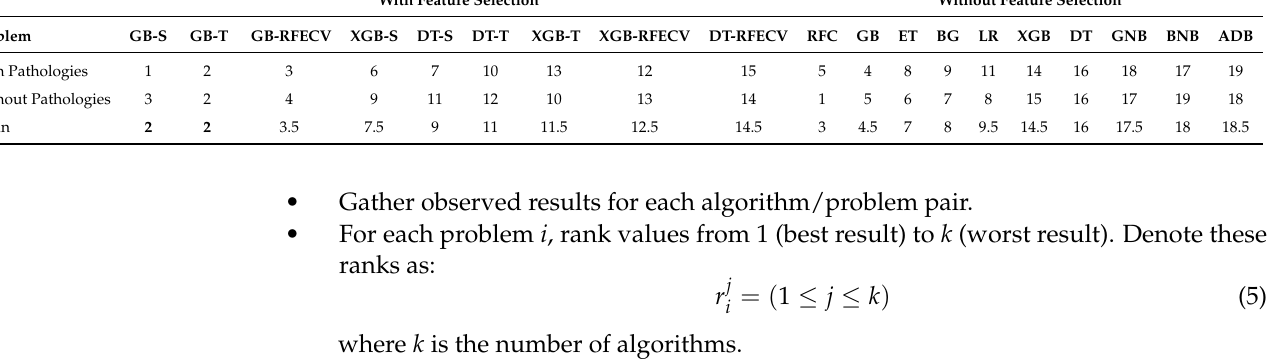
Table 6. Friedman Ranks for the different proposed algorithms. With Feature